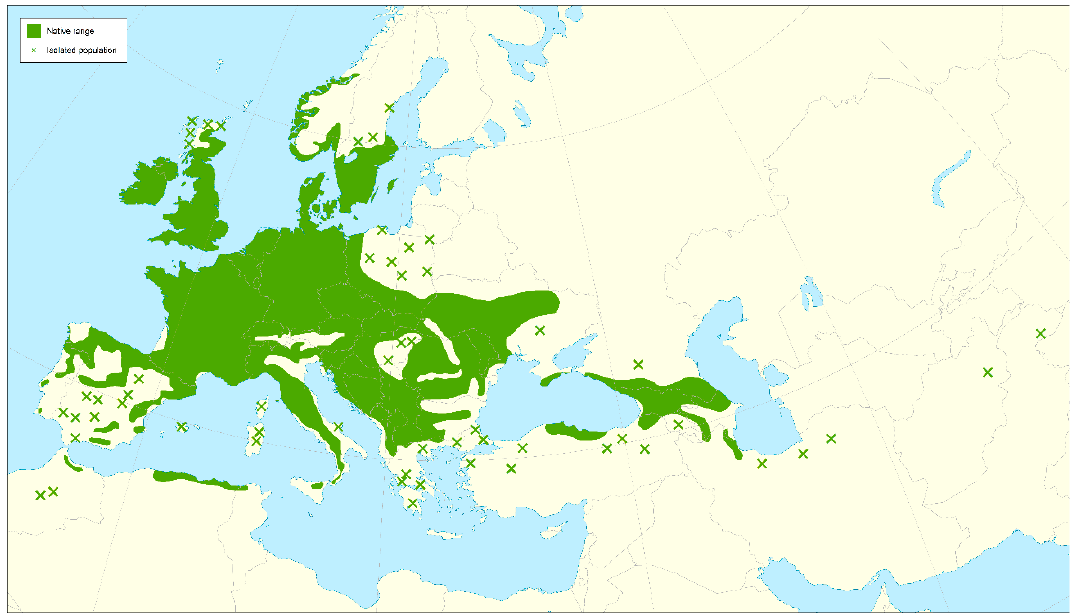
Figure 6. Prunus avium L. distribution map [62]. https://commons.wikimedia.org/wiki/File:Prunus_avium_range.svg